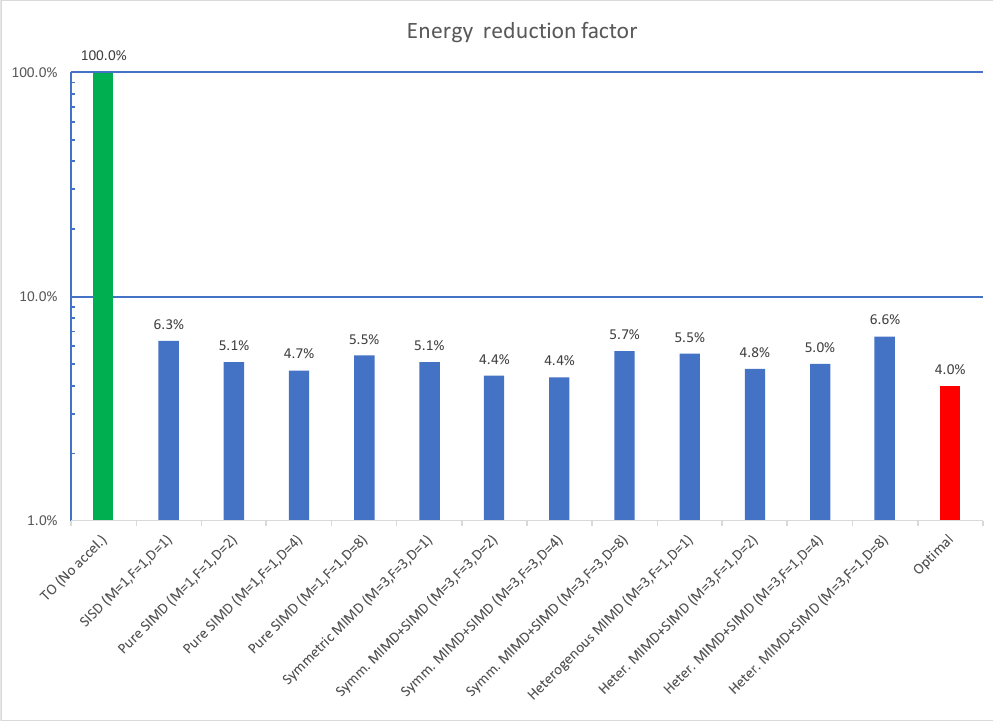
Figure 18. Total energy consumption [J] of the most energy efficient coprocessor configuration and of the non-accelerated T0 core, per layer.